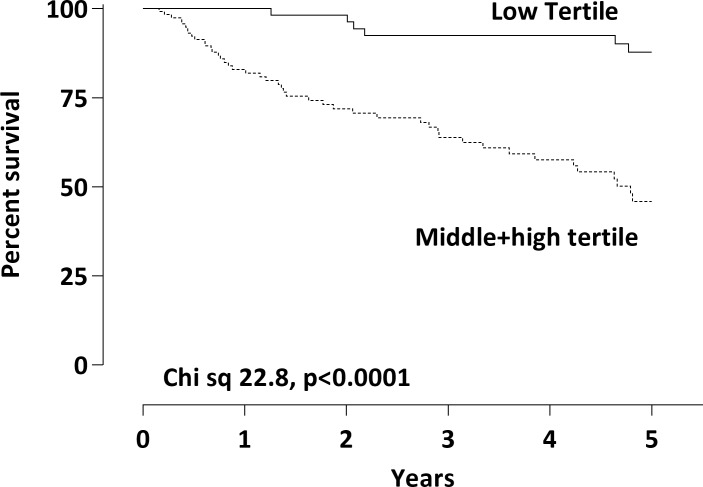
Kaplan-Meier analysis of TMAO levels and all-cause mortality in CKD 3–5 patient (n = 179).Data presented as tertiles. CKD patients with the highest TMAO levels (Combined middle (32.2–75.2 μM/L) + high tertile (>72.2 μM/L)) had a significantly lower survival compared with patients in the lowest TMAO tertile.